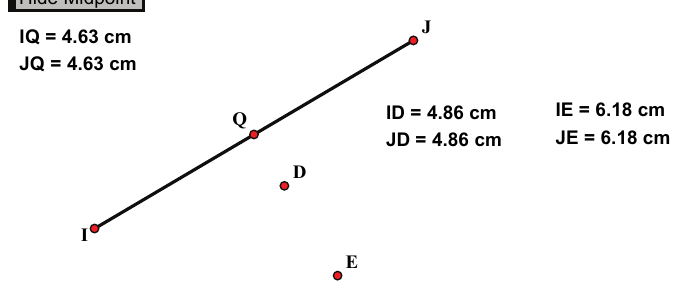
Figure 8 : Using the perpendicular